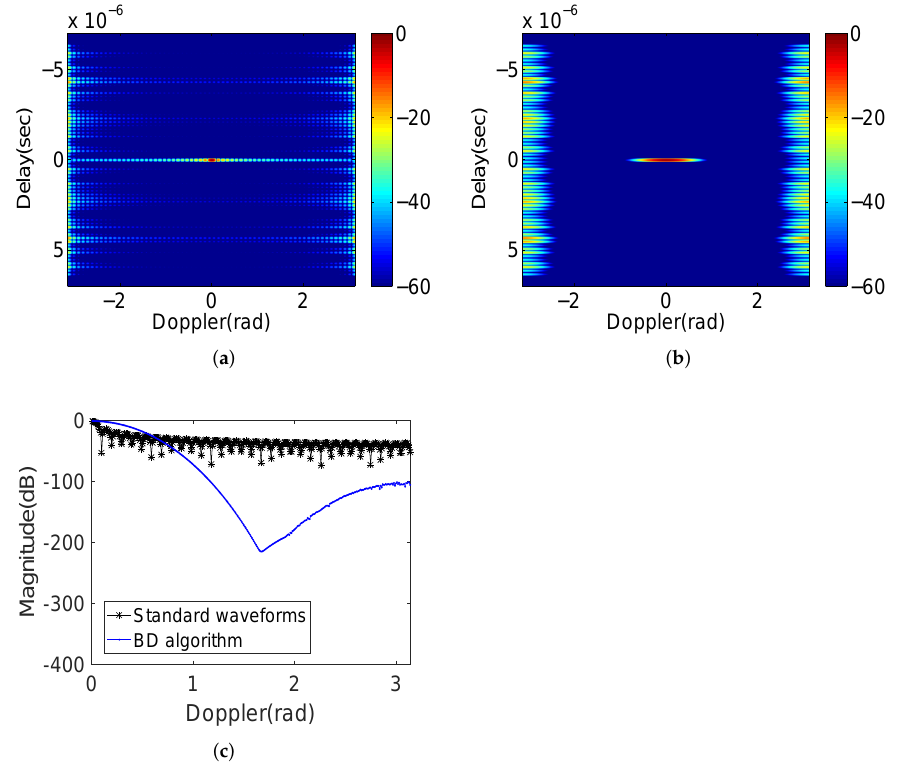
Figure 1. The ambiguity function of Golay complementary waveforms based on ( a ) standard trans- mission order and weighting sequence; ( b ) the BD algorithm; ( c ) Slices at Delay = 0. (unit in the colorbar is dB and the parameters setting of this figure are described in Appendix